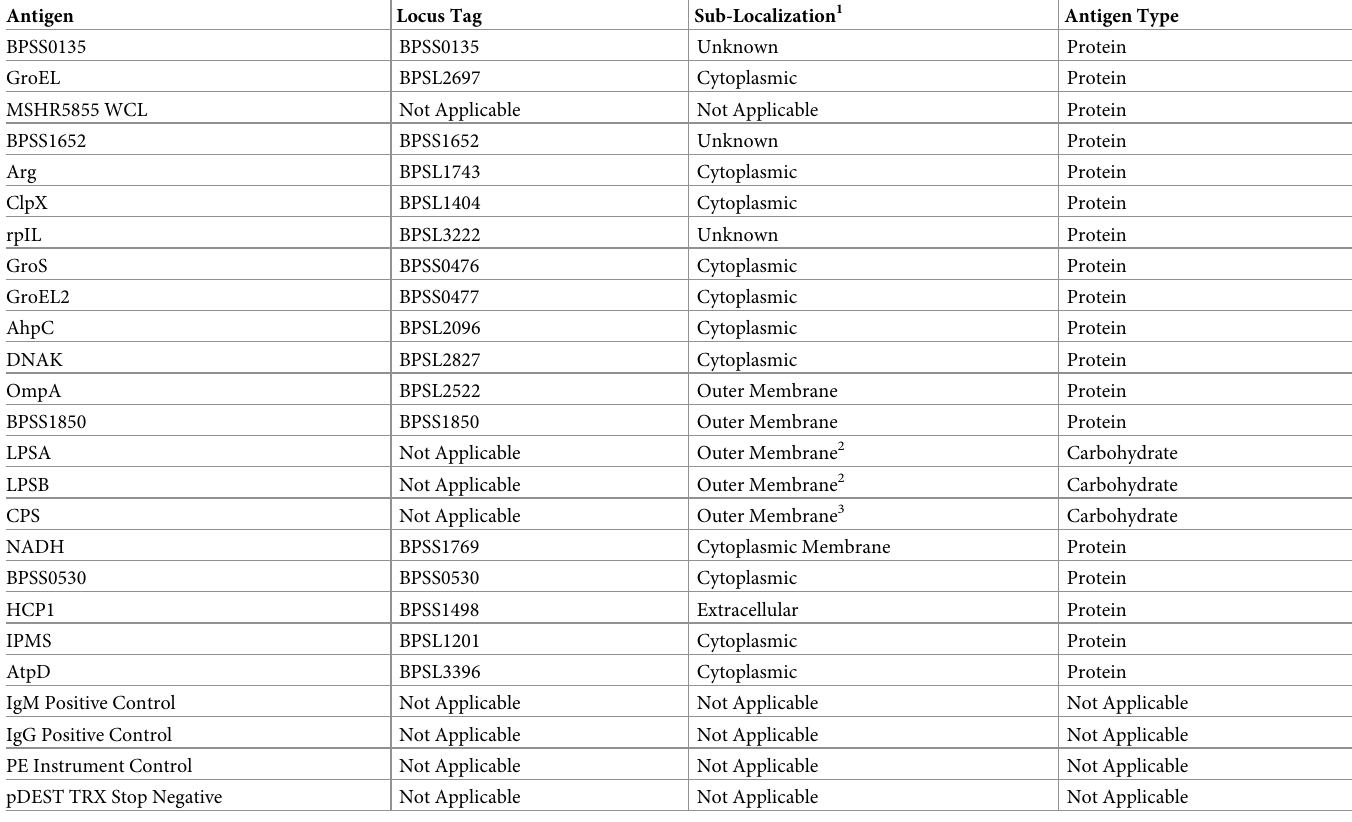
Table 1. B . pseudomallei proteins, carbohydrates, and assay controls comprising the BurkPx multiplex serological